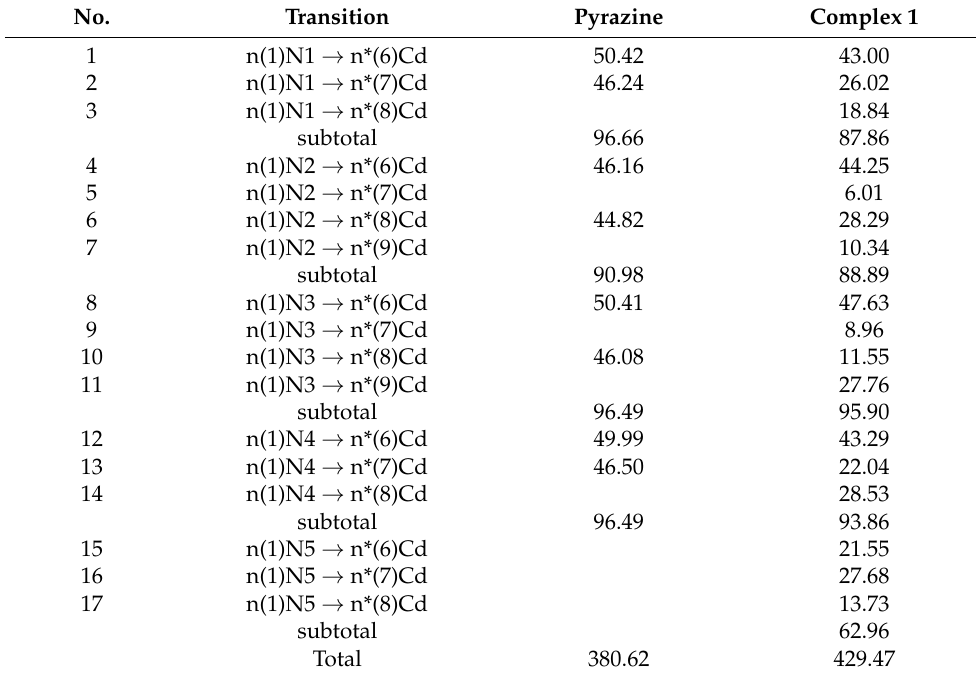
Table 3. Estimation of the hyperconjugative energies (kcal/mol) of complex 1 . Most relevant values are